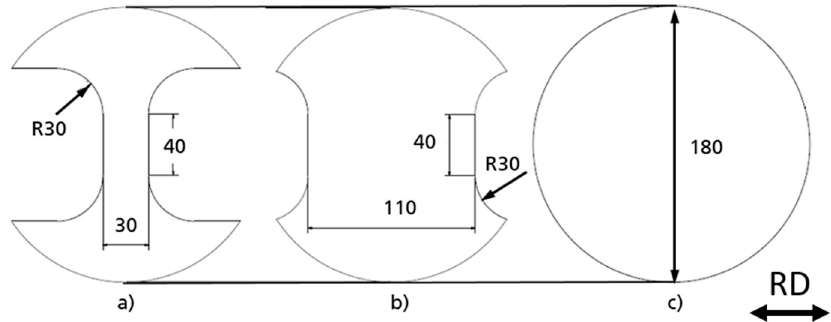
Figure 4. Geometries of Nakajima specimens, all measurements given in mm. ( a ) With a width of 30 mm (UAN), ( b ) with a width of 110 mm (PSN) and ( c ) disk-shaped specimen (EBN).